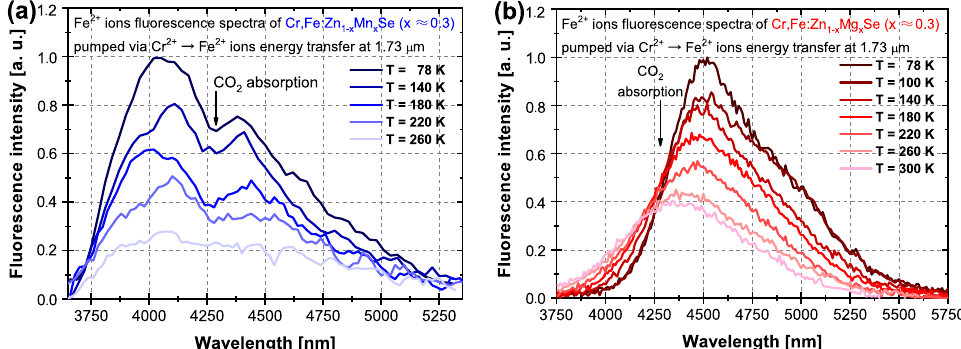
Figure 6. Temperature dependence of the Fe 2 + fluorescence spectra excited via the Cr 2 + → Fe 2 + ion energy transfer at the wavelength of 1.73 µ m. ( a ) Cr,Fe:Zn 1 − x Mn x Se (x ≈ 0.3)—blue curves. ( b ) Cr,Fe:Zn 1 − x Mg x Se (x ≈ 0.3)—red